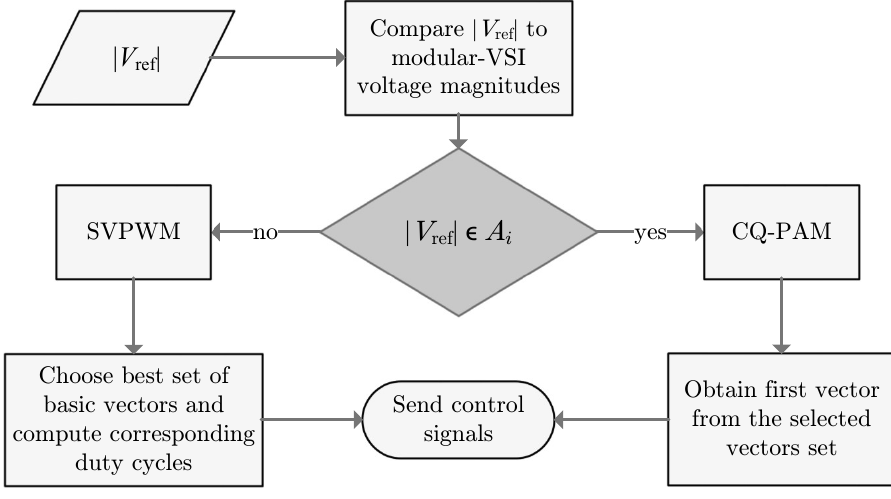
Figure 7. Control algorithm diagram.